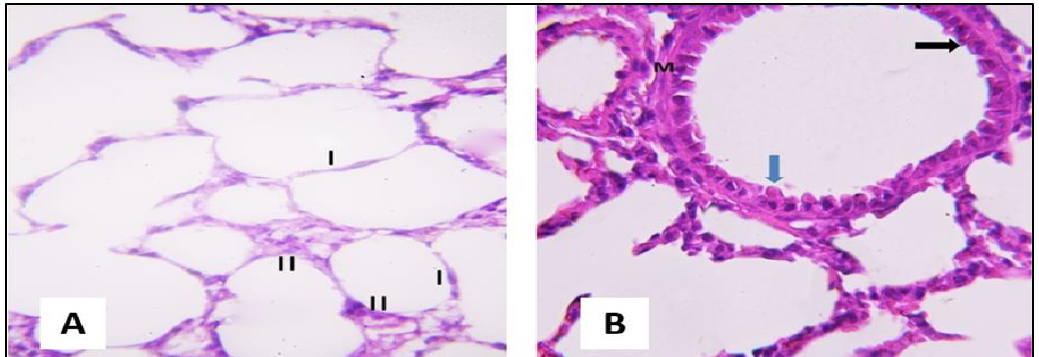
Figure 4. Section of a rat lung of the control (group I) showing the following features. ( A ) A normal lung architecture with thin interalveolar septa and patent alveolar sacs. A thin type I pneumocyte with flat nuclei (I) was noticed, and a small number of cuboidal type II pneumocytes with their large, rounded nuclei and vacuolated cytoplasm (II) were present at the angles of the interalveolar septa (H&E, ×400). ( B ) The bronchiole is lined by simple columnar epithelium (black arrow) and is surrounded by concentric layers of smooth muscle fibers (M). Club cell is observed in the lining of the bronchiole (blue arrow) (H&E, ×400).